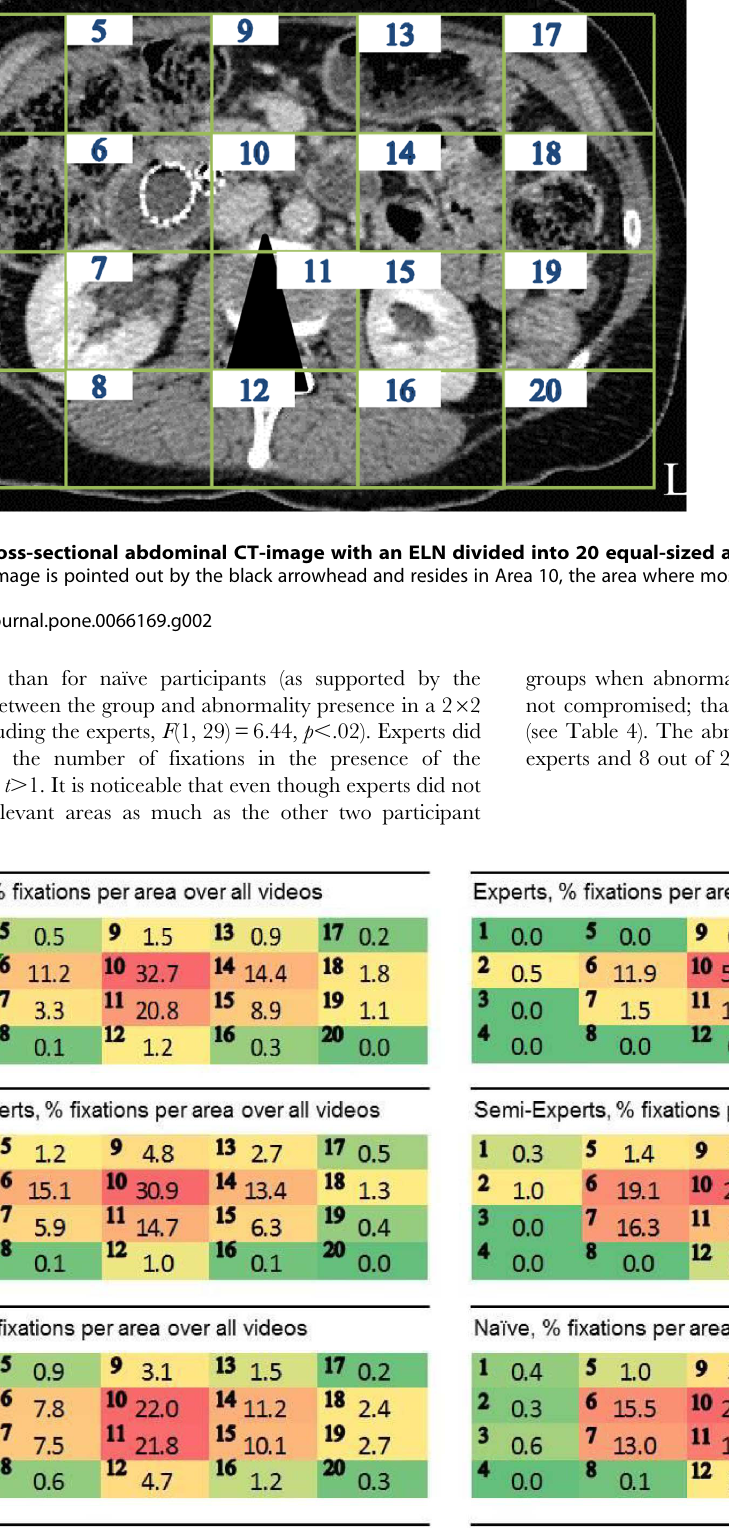
Figure 3. Heatmaps of the distribution of fixations over all 20 areas for each participant group. The left panels include all fixations over all videos; the right panels depict the fixation distributions for images in ELN videos where enlarged lymph nodes are present.